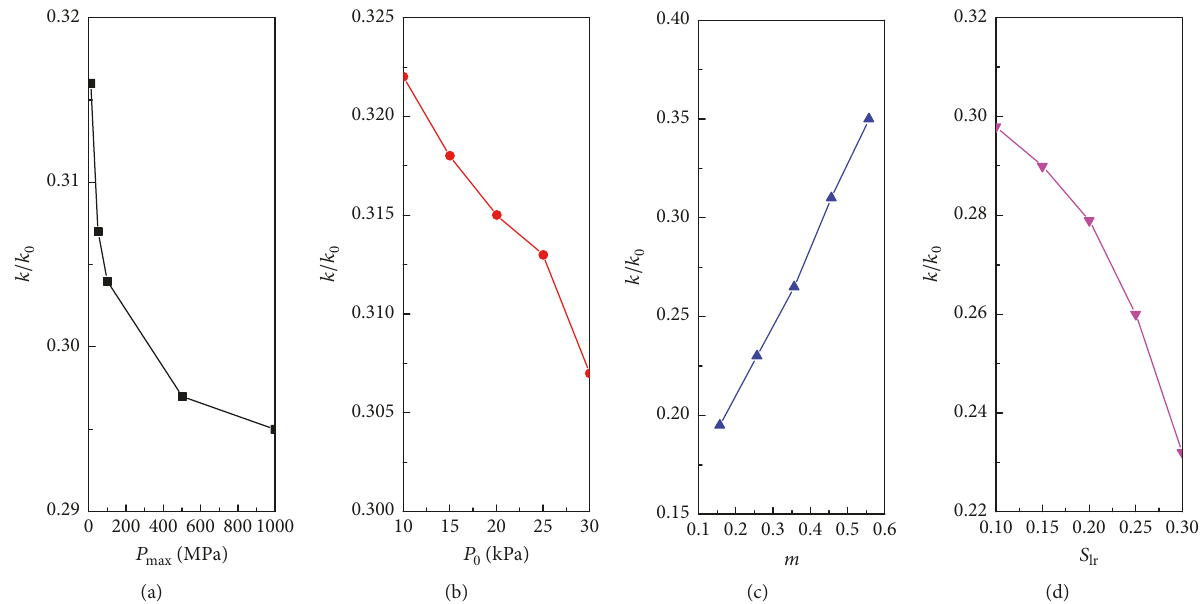
Figure 14: Relationship between parameter change and permeability impairment near the injection well [11].